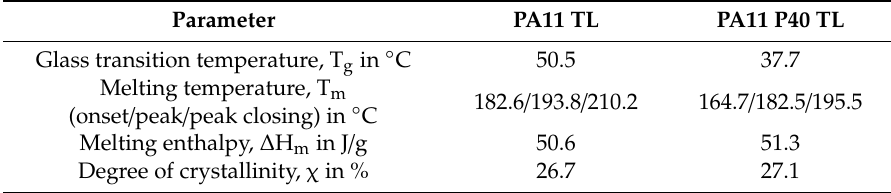
Table 1. Main calorimetric properties of the polymer